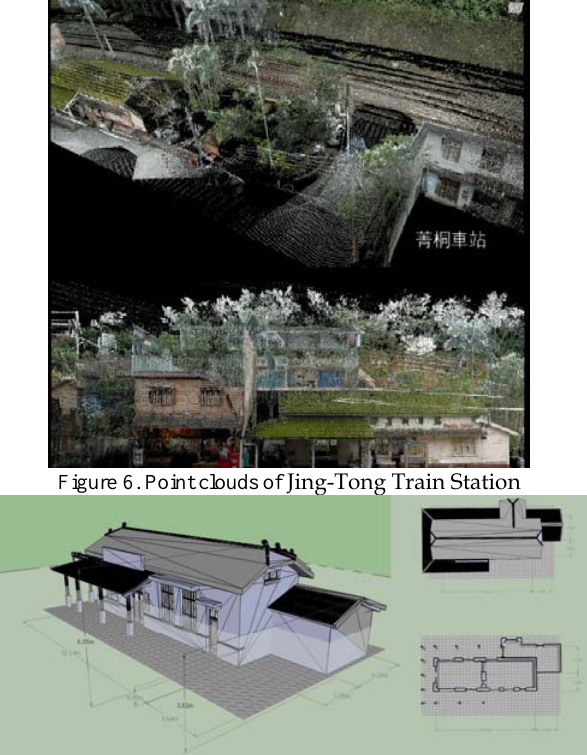
Figure 7. 3D Documentation (Jing-Tong Train Station)